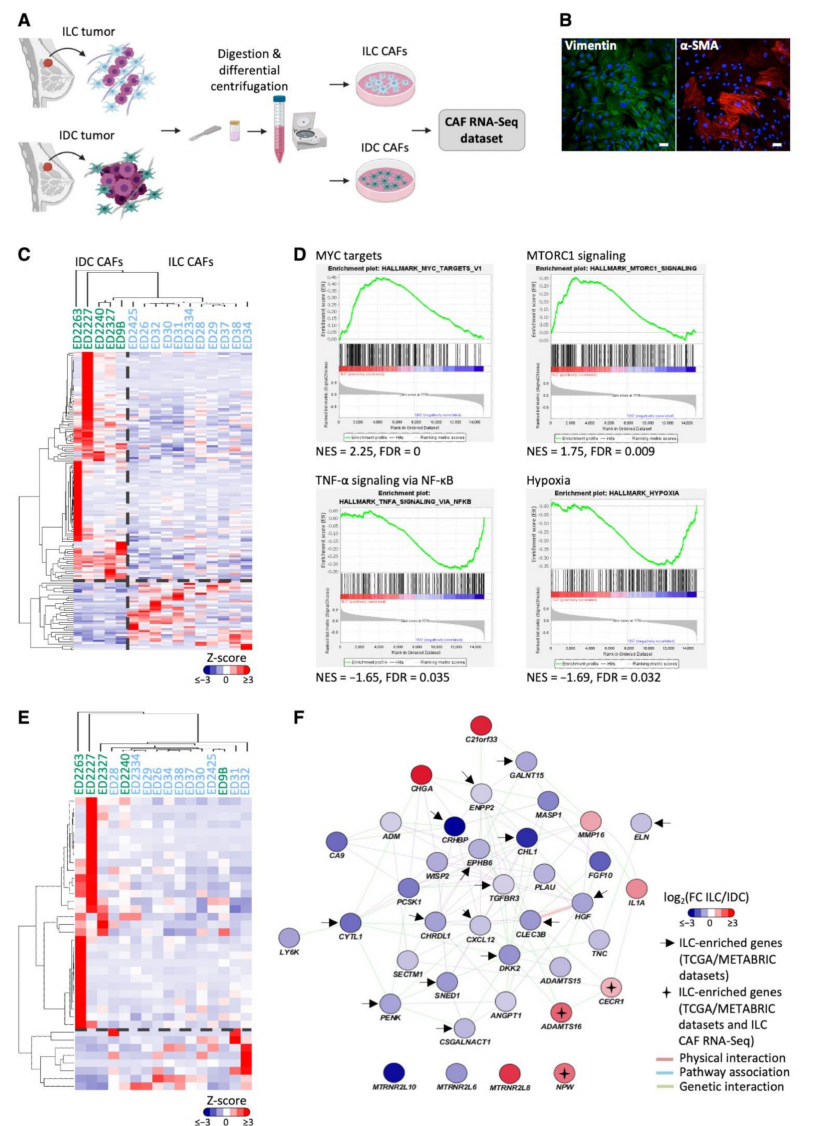
Figure 3. Generation of a primary CAF dataset identifies genes and pathways specifically enriched in either ILC or IDC CAFs. ( A ) Schematic representation of primary CAF dataset generation made in Biorender.com (accessed on 1 June 2020). ( B ) Primary ED2425 ILC CAFs stained for the mesenchymal markers vimentin (green) and α -SMA (red). Scale bar, 50 µ m. ( C ) Differential gene expression between ILC and IDC CAFs determined by likelihood ratio test (EdgeR, glmFit). Heatmap of significantly differentially expressed genes (FDR < 0.05) was generated using Cluster 3.0 and TreeView. Z-scored expression values are shown. ( D ) Gene set enrichment analysis of ILC and IDC CAF gene expression. Significant hallmark gene sets FDR < 0.05. ( E ) Heatmap of significantly differentially expressed secreted genes (FDR < 0.05) between ILC and IDC CAFs determined by likelihood ratio test (EdgeR, glmFit) generated using Cluster 3.0 and TreeView. Z-scored expression values are shown. ( F ) Gene- MANIA network created in Cytoscape showing the 38 significantly differentially expressed secreted protein encoding genes between ILC and IDC CAFs in the RNA-Seq dataset. Positive log fold-change shows higher expression in ILC CAFs (in red) and negative log fold-change shows higher expression in IDC CAFs (blue). Arrows indicate genes upregulated in ILC tumors compared to IDC tumors in 2 out of 3 bulk tumor datasets (METABRIC, TCGA RNA-Seq and Microarray datasets), with crosses indicating genes upregulated in both ILC CAFs and tumors. Network connectors represent physical interactions (pink), pathway associations (blue) or genetic interactions